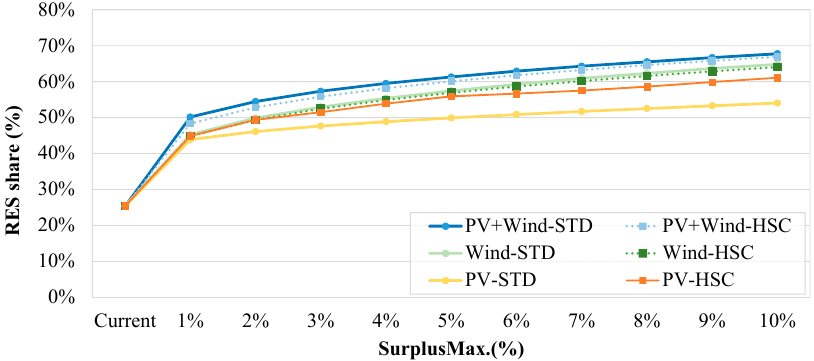
Figure 12. Variable renewable energy (VRE)-wind and solar PV-share for the di ff erent scenarios using di ff erent Surplus Max. values.